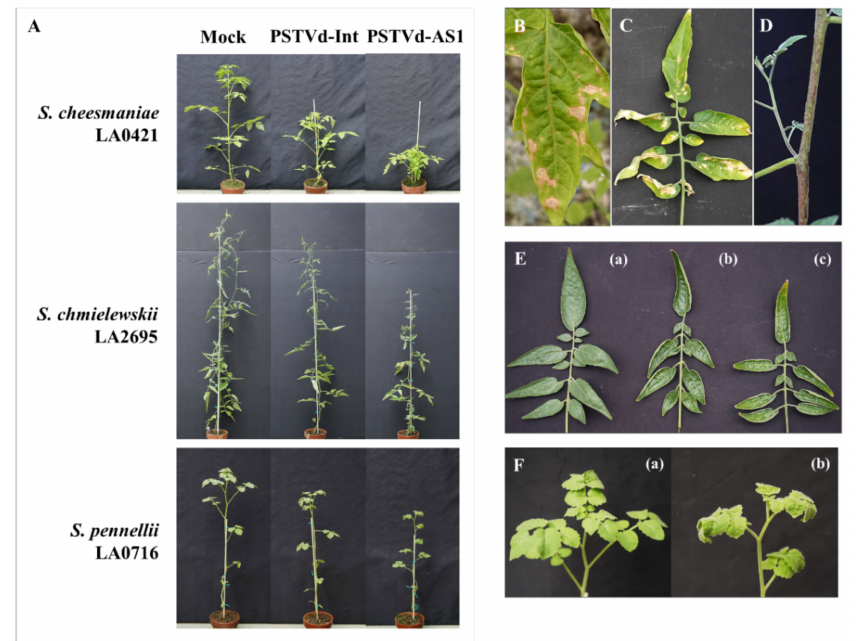
Figure 4. Wild tomato relatives showing characteristic symptoms during PSTVd infection. ( A ) In S. cheesmaniae LA0421, S. chmielewskii LA2695, and S. pennellii LA0716, clear symptoms including stunting and leaf miniaturization were observed after PSTVd infection. ( B – D ) Necrosis was observed in wild tomato relatives infected with PSTVd-AS1. ( B ) Leaf necrosis in S. cheesmaniae LA0421. ( C ) Leaf necrosis, accompanied by yellowing, and ( D ) stem necrosis in S. chmielewskii LA2695. ( E ) Leaf rolling was observed in PSTVd-infected S. chmielewskii LA2695 plants ((a), mock; (b), PSTVd-Int; (c), PSTVd- AS1). ( F ) S. pennellii LA0716 clearly exhibited leaf curling after PSTVd-AS1 infection ((a), mock; (b), PSTVd-AS1).